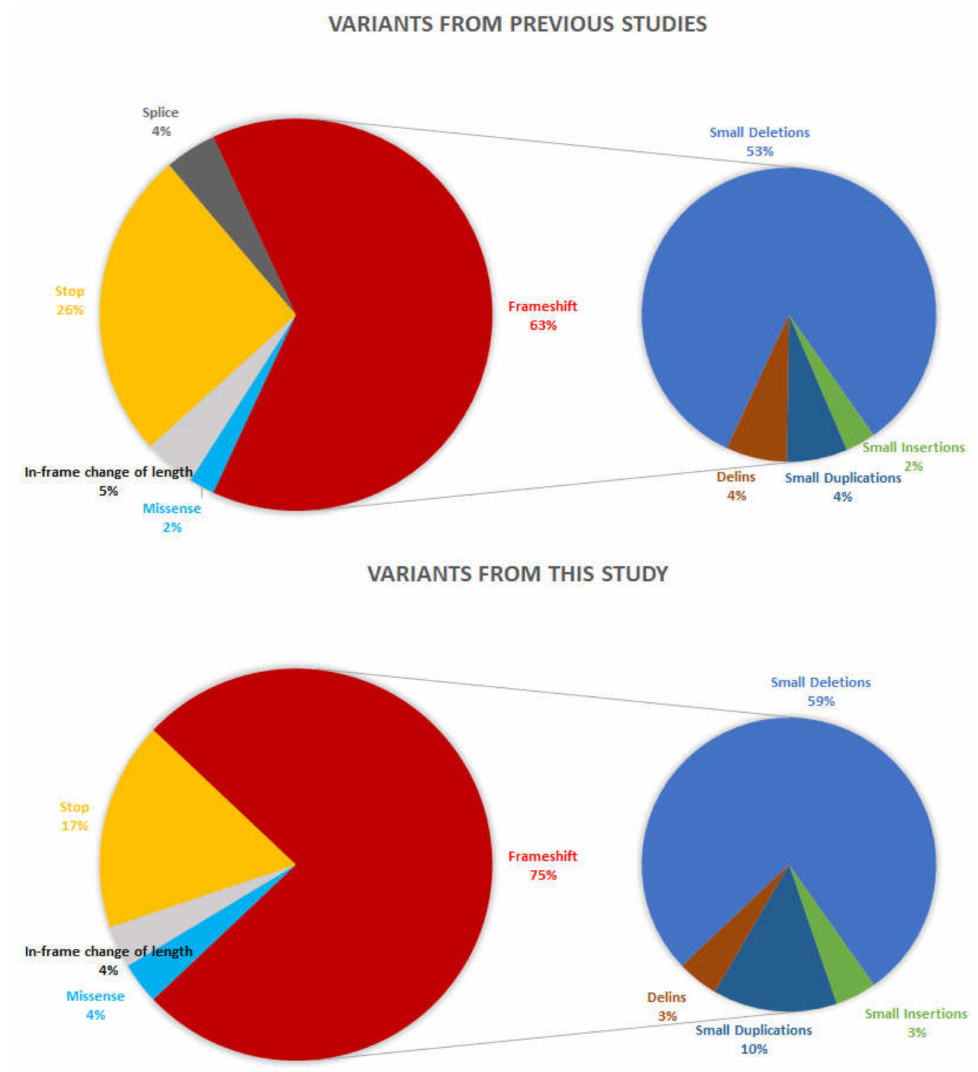
Figure 4. Pie charts showing the distribution of the RPGR ORF15 variants underlying cone/cone-rod dystrophies according to their types. The distribution of the variants that have previously been published by other groups is depicted at the top. Variants reported in the present study are on the